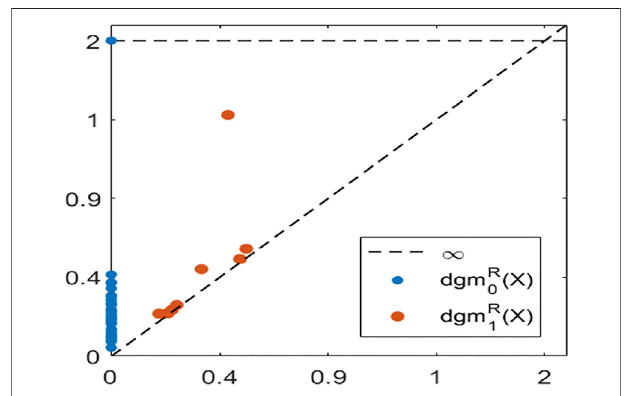
FIGURE4|(A) AnexampleapplefromMPEG7data. (B) AnexampleimagecontourusedforMPEG7. (C) Thedistancetomeanpointcalculationusedforsublevel set persistence (D) Persistence diagrams from lower star persistence (E) Persistence diagrams from the contour.